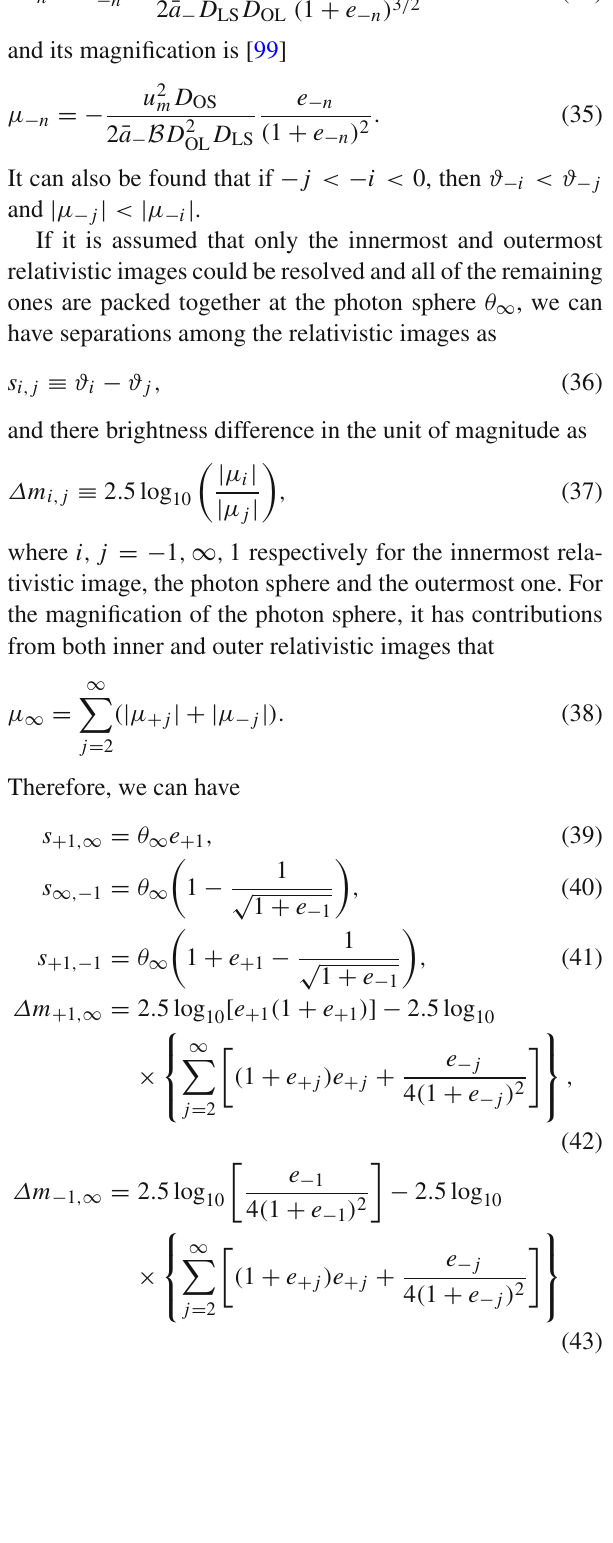
less and irrelevant to these two quantities of the lens.